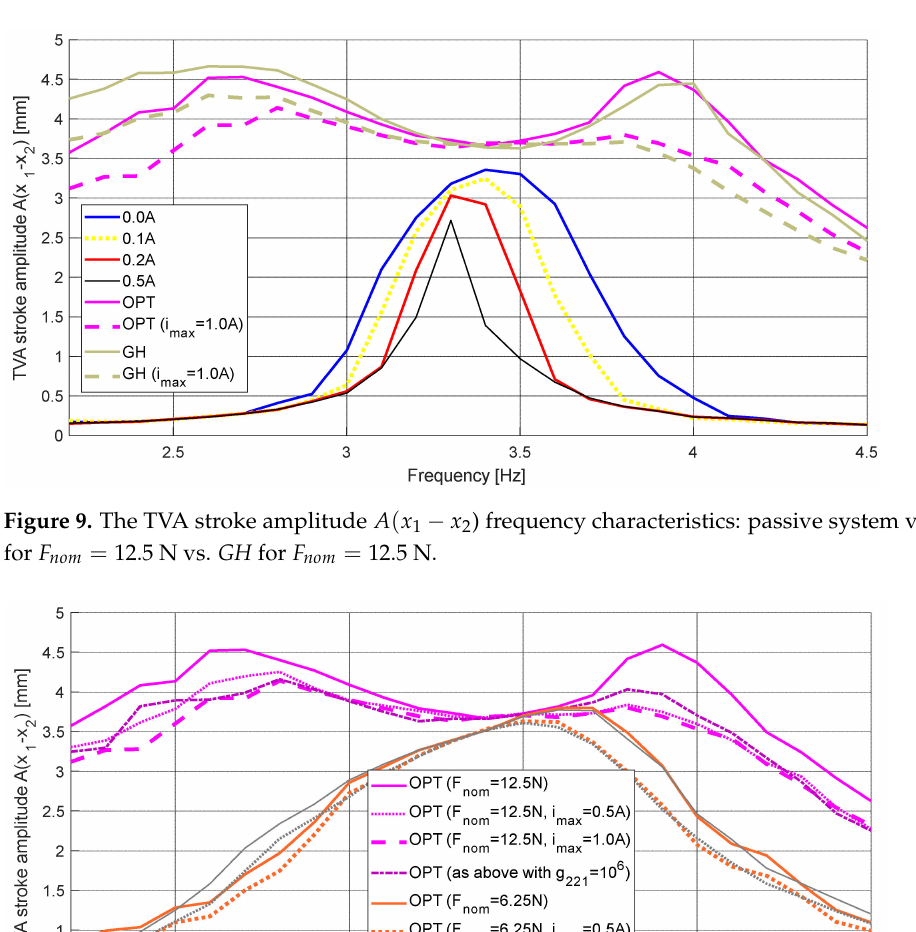
Figure 8. Nacelle horizontal displacement amplitude A ( x 1 ) frequency characteristics: OPT for different i max d g 23 values, and F nom = 12.5 N.